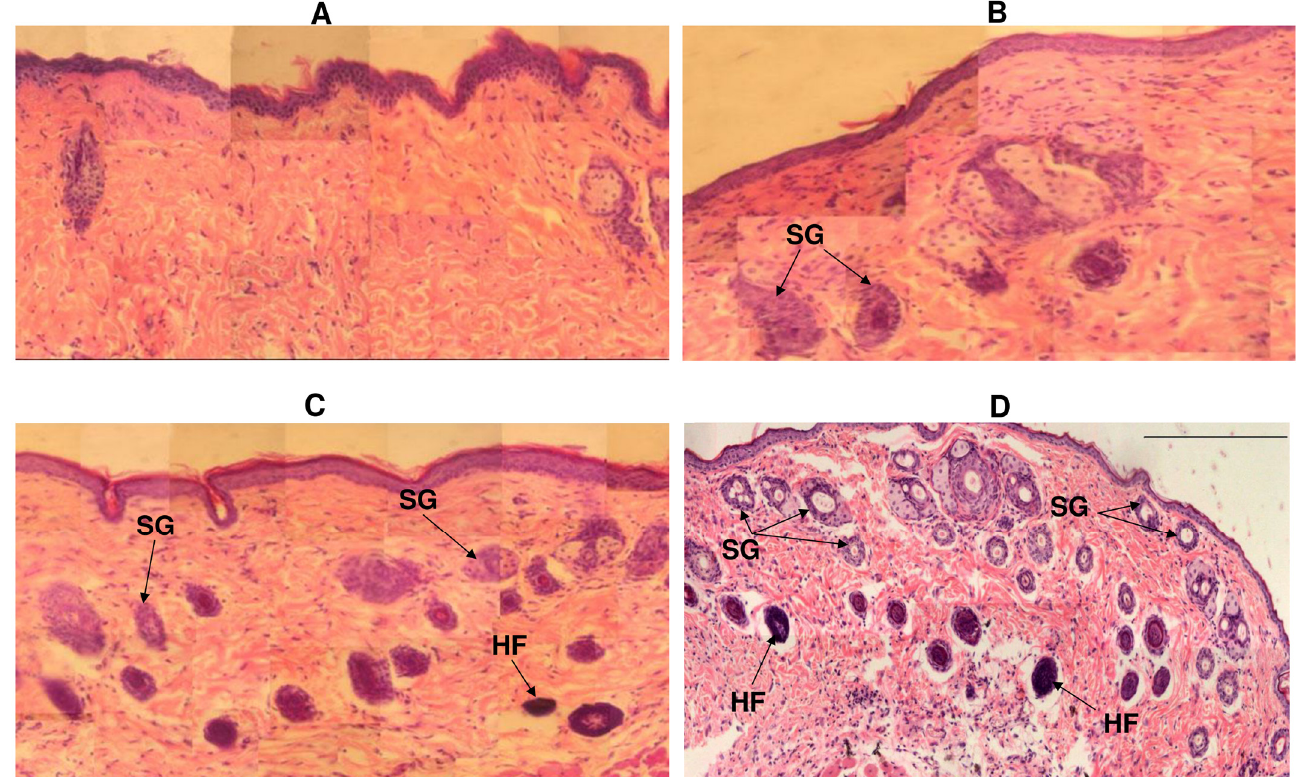
Figure 7. Histological sections from the skin defect site under different types of wound dressings: ( A )—control; ( B )—solvent-cast film; ( C )—aligned nanomembrane; ( D )—random nanomembrane. Notations: SG—sebaceous glands, HF—hair follicles. Hematoxylin and eosin staining, 100×. Wound healing (day 10 after defect creation).